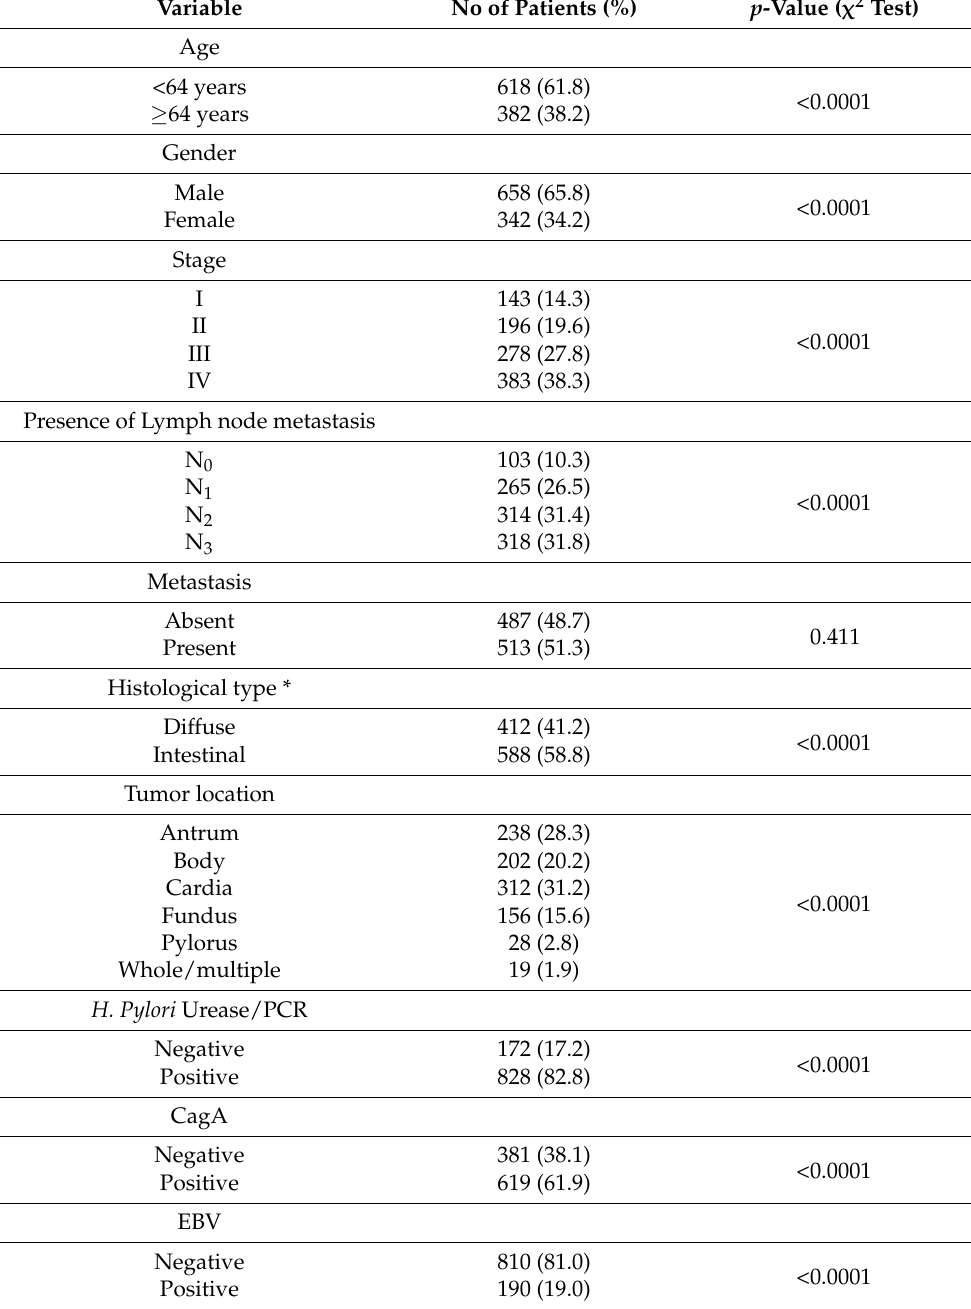
Table 1. Clinicopathological